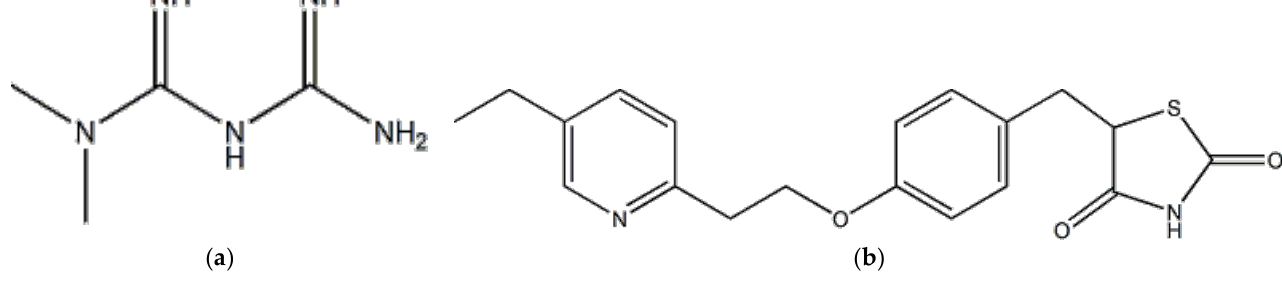
Figure 1. Chemical structures of ( a ) metformin and ( b )